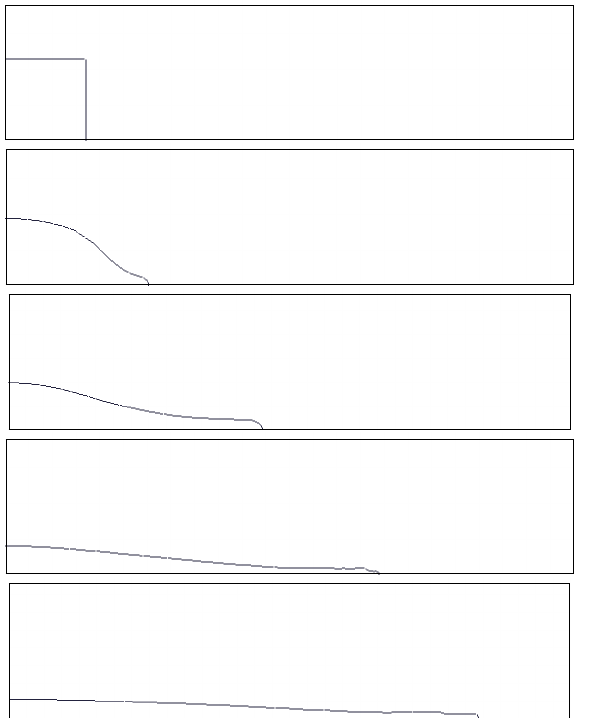
Figure 6. Evolution of the interface for the dam break problem at non-dimensional times (cid:112) T = t g / H = 0,1,2,3,4.